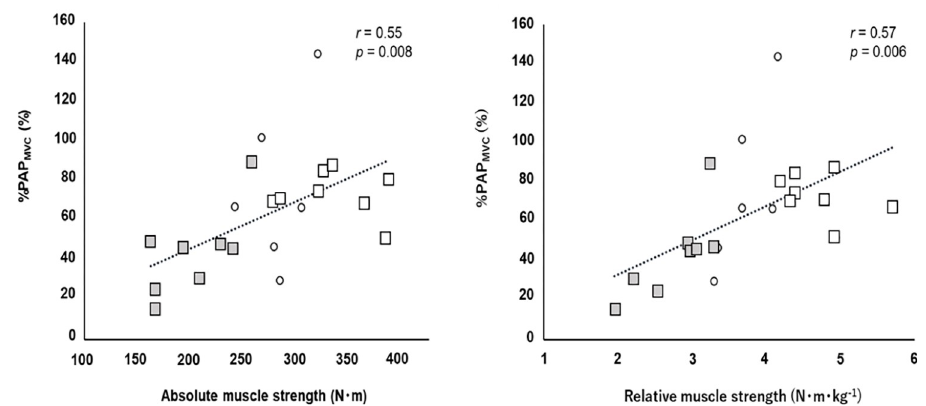
Fig 2. Correlation between %PAP MVC and absolute ( A ) and relative ( B ) muscle strength. Filled squares, open squares, and open circles represent the weaker, stronger, and intermediate levels of the relative muscle strength, respectively.